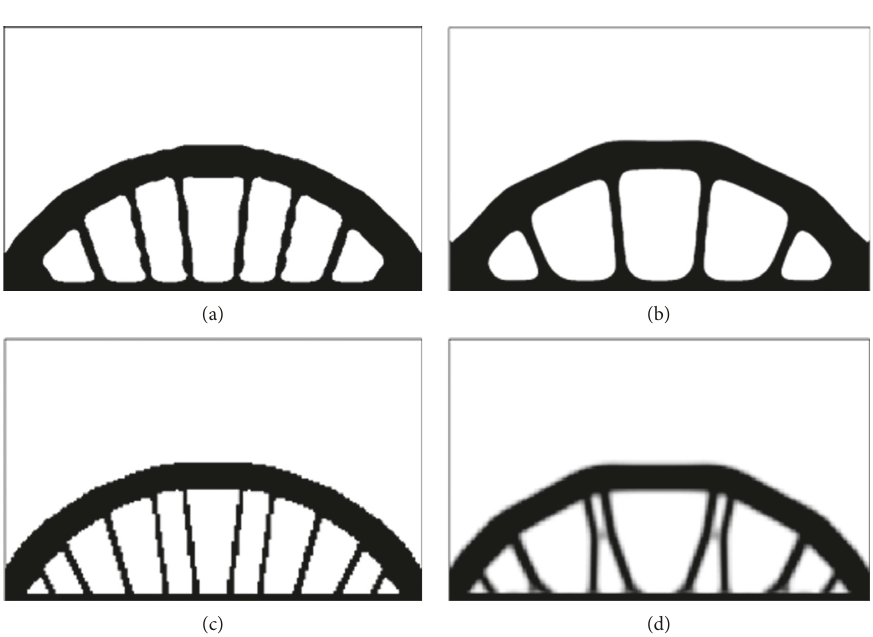
Figure 10: The optimal layout of through arch bridge by different methods: (a) PLSM, (b) CLSM, (c) BESO, and (d) SIMP.